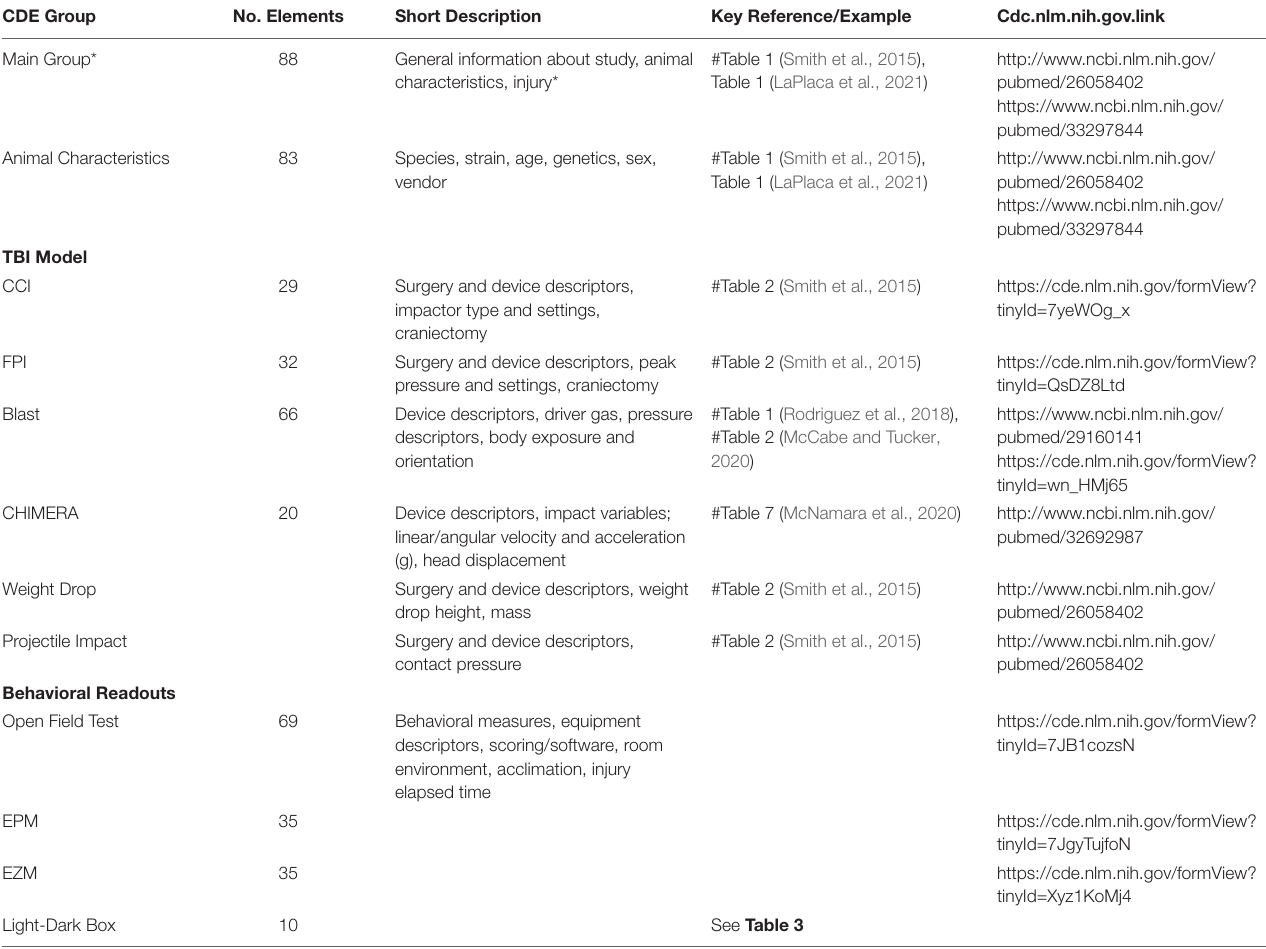
TABLE 2 | Common data element Links at FITBR for Preclinical Study of TBI and Anxiety. CDE Group No.